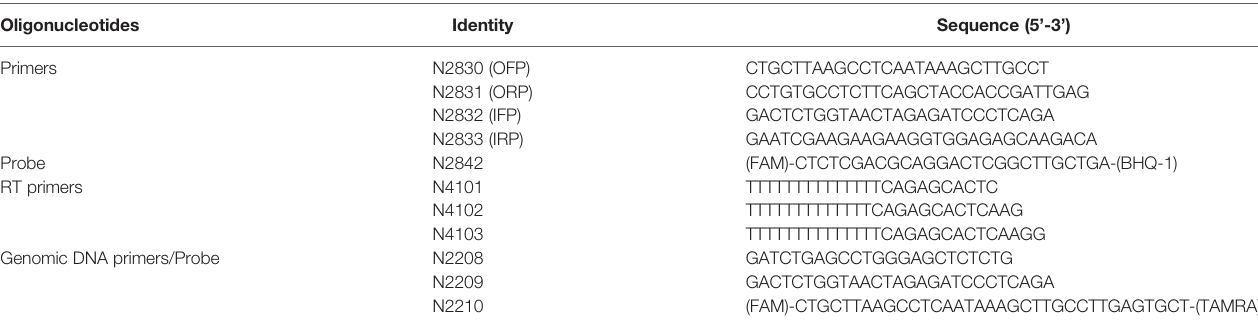
TABLE 1 | Sequences of primers and probe used for PCR and cDNA synthesis. Oligonucleotides Identity Sequence (5 ’ -3 ’ )